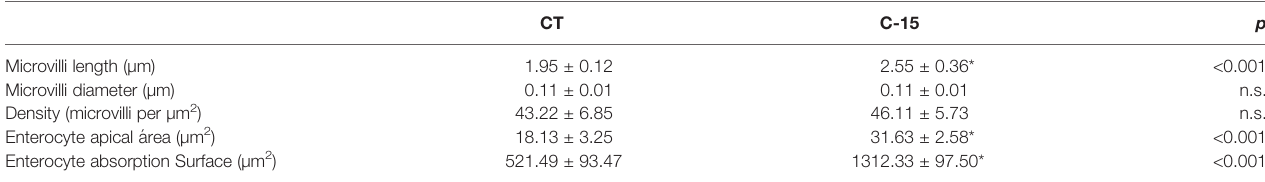
TABLE 8 | Microvillar morphology of juvenile C. labrosus fed control (CT) and C-15 diets during 90